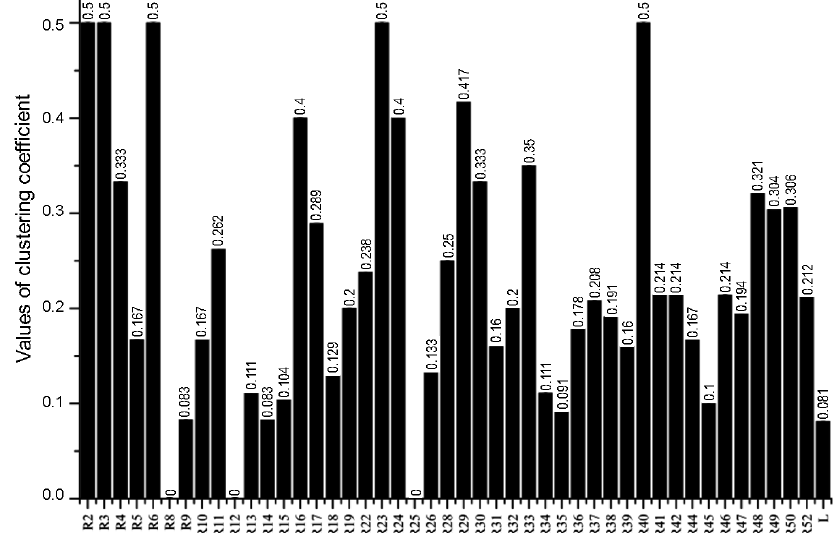
Figure 8. Clustering coefficient of each